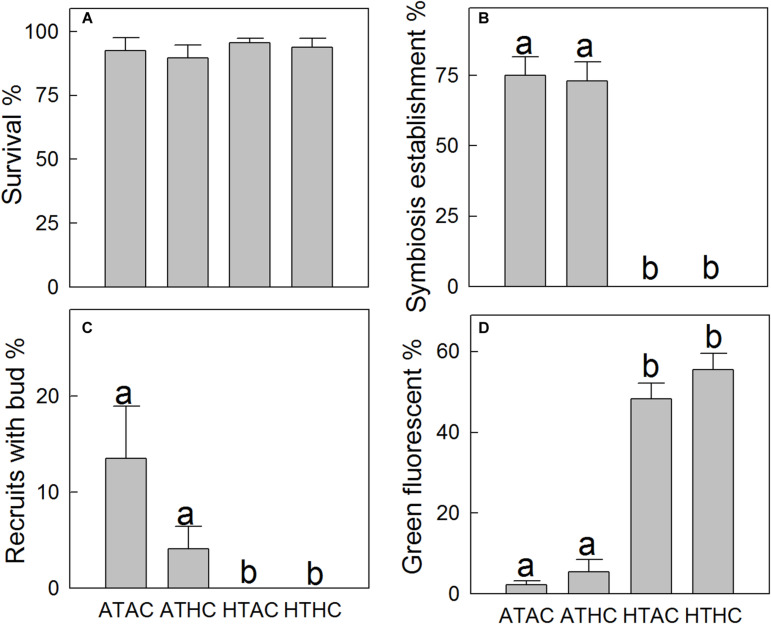
Mean (±SE) survival (A, n = 32), symbiosis establishment (B, n = 32), budding (C, n = 32), and green fluorescence (D, n = 32) of juvenile Acropora intermedia under the four treatments after 33 days. Treatment conditions were as follows: ATAC (28°C and pCO2 ∼600 μatm), ATHC (28°C and pCO2 ∼1,200 μatm), HTAC (30.5°C and pCO2 ∼600 μatm), HTHC (30.5°C and pCO2 ∼1,200 μatm). The significance of difference within pairs of groups was assessed using the Bonferroni test (P < 0.05, different letters indicate statistically significant differences).